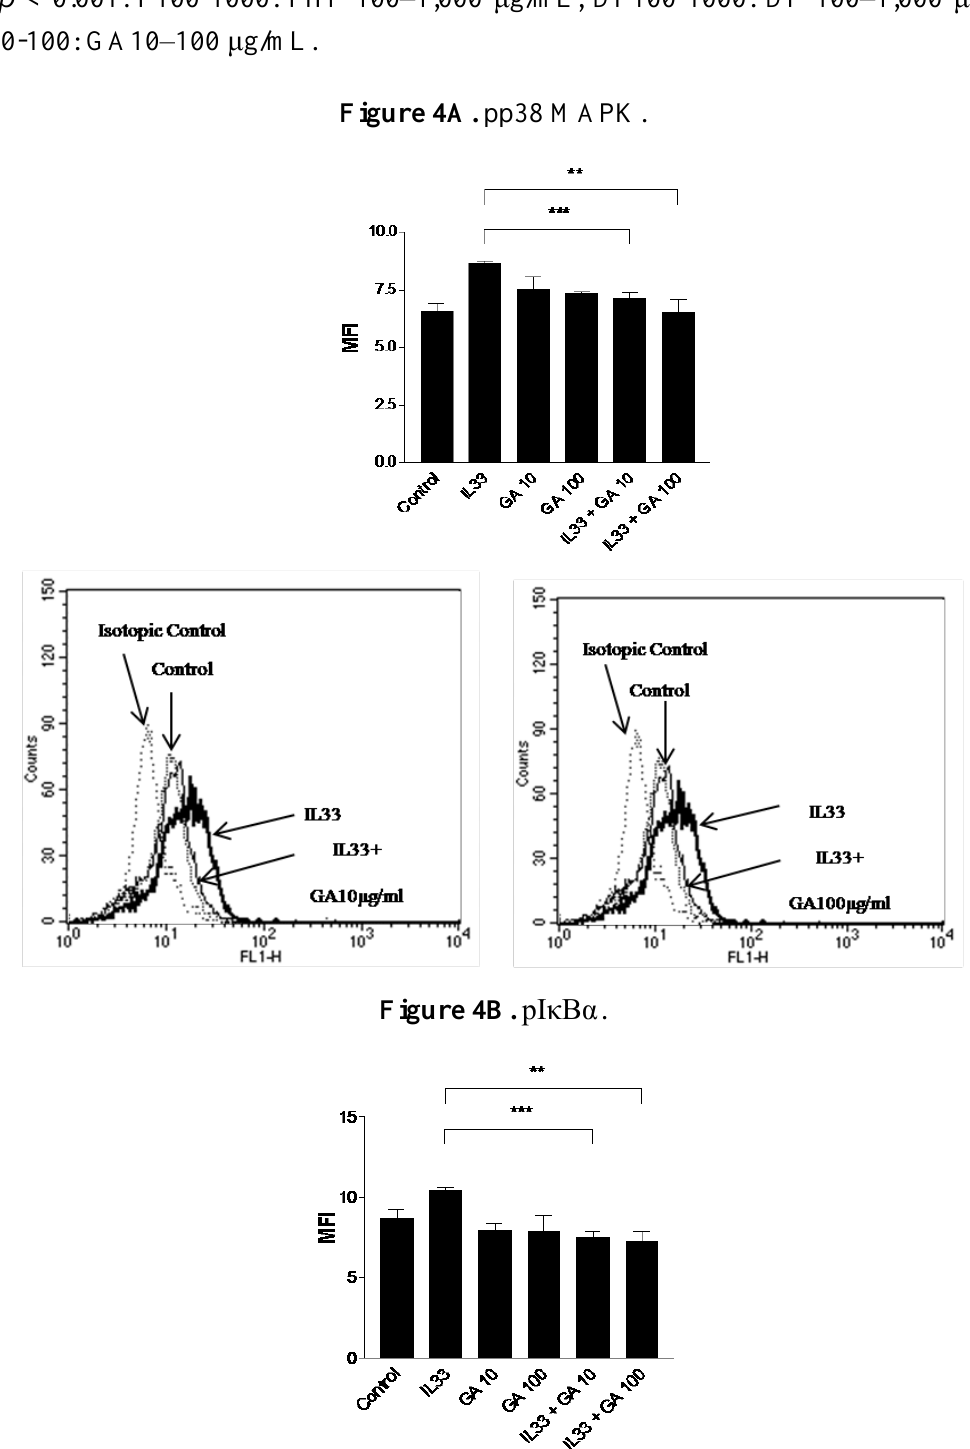
Figure 4. Suppressive effects of IL-33-induced-intracellular signaling molecules by 15-min treatment with GA in KU812 cells. ( A ) phosopho (p) p38 MAPK pretreated with IL-33 (30 min); ( B ) pIκBα pretreated with IL-33 (1 h); ( C ) pJNK pre-treated with IL-33 (30 min) and ( D ) pJNK pretreated with IL-33 (1 h). Results are shown as the mean plus SEM of MFI and normalized by subtracting appropriate isotypic control of three independent experiments in bar charts. Representative histograms of intracellular expression of phosphor-signaling molecules in KU812 cells were also shown. * p < 0.05, ** p < 0.005, *** p < 0.001. P100-1000: PHF 100–1,000 μg/mL, DP100-1000: DP 100–1,000 μg/mL, GA10-100: GA10–100 μg/mL. Figure 4A. pp38 MAPK.